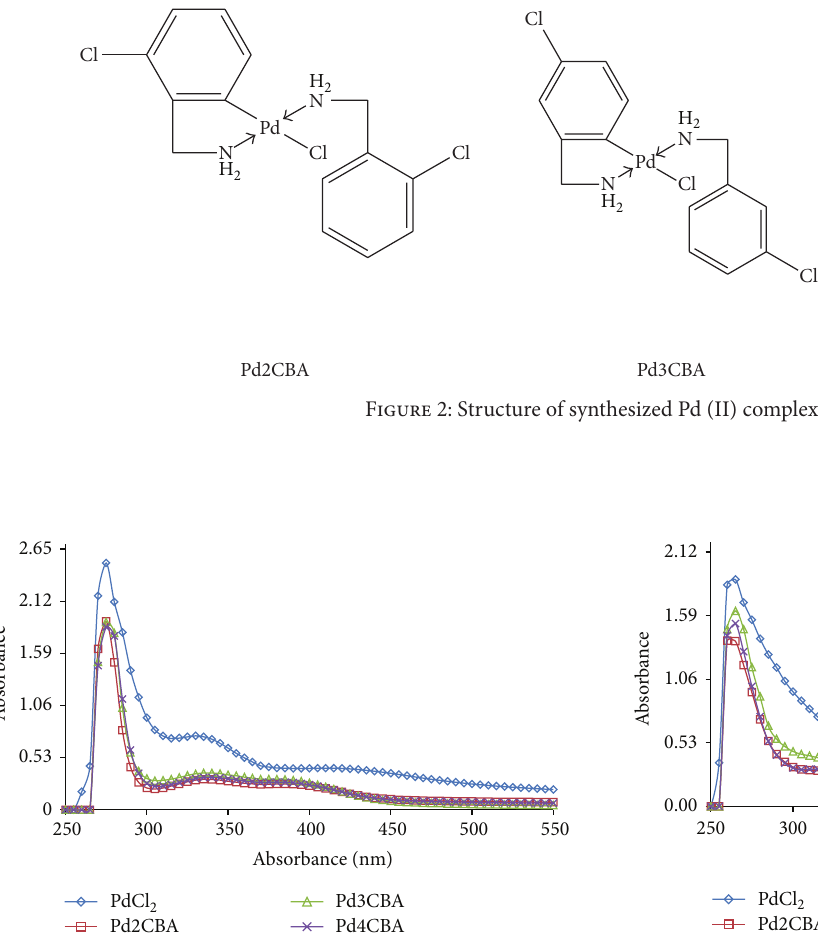
Figure 5: UV spectra of Pd (II) complexes in DMSO :phosphate buffer at 7.2